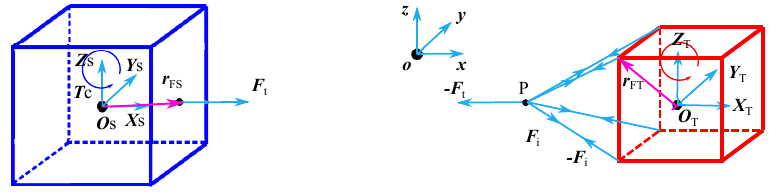
Figure 5. Concept of the modified dumbbell model for sub-tether